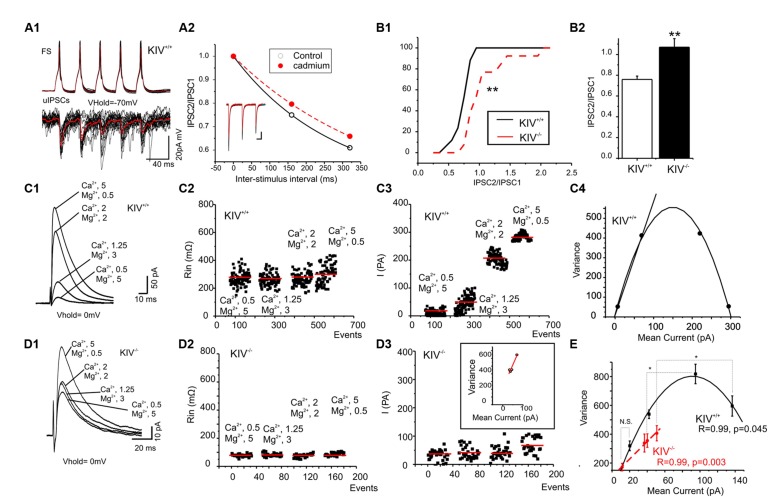
Altered presynaptic GABAergic transmission in KIV–/– mice. (A) Paired recordings from a pair of synaptic connected cells in layer IV of a wild-type mouse. Repetitive action potentials (top) in a FS cell induced GABAergic uIPSCs (bottom) in the post-synaptic spiny stellate cell (A1). The averaged uIPSCs (red trace in the bottom) showed a short-term depression, which was reduced by calcium channel blocker cadmium (100 μM, A2). (B) The characteristic paired-pulse depression of eIPSCs in spiny stellate cells of wild-type mice was abolished in KIV-/- mice. n = 8 cells in each group. (C,D) IPSCs were evoked in the presence of different extracellular Ca2+/Mg2+ ratios (C1,D1) in wild-type (C, n = 8) and KIV-/- mice (D, n = 8). The input resistance (C2,D2), and amplitude (C3,D3) of each evoked IPSC event was plotted against experimental time. (C4,D4) V–M analysis of the same experiments of C1,D1. (E) The V–M analysis of all wild-type mice (black squares) and KIV-/- mice (red circles), statistical analysis were performed between amplitude of eIPSCs evoked in the same conditions. *p < 0.05; **p < 0.01.